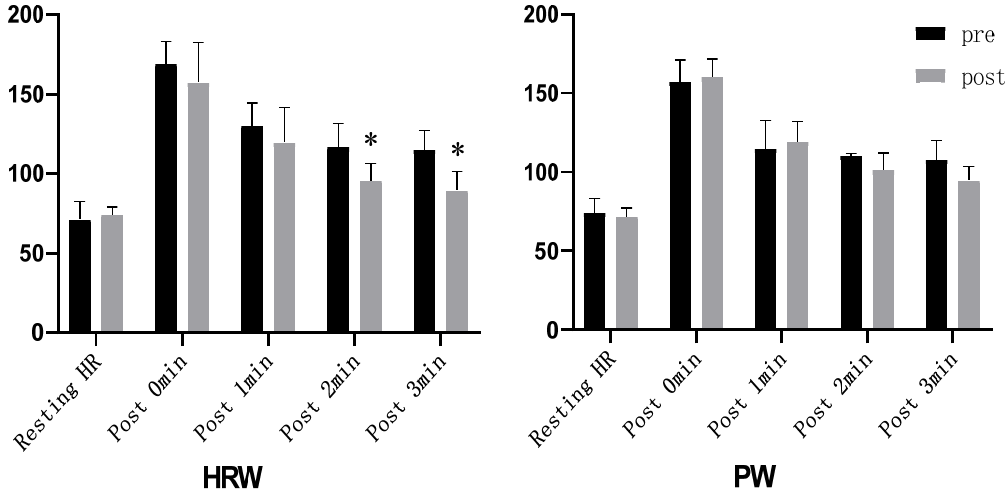
Figure 1. Heart rate changes after the rowing test. * Indicates that there is a statistically significant difference between the groups after the intervention and before the intervention, p <